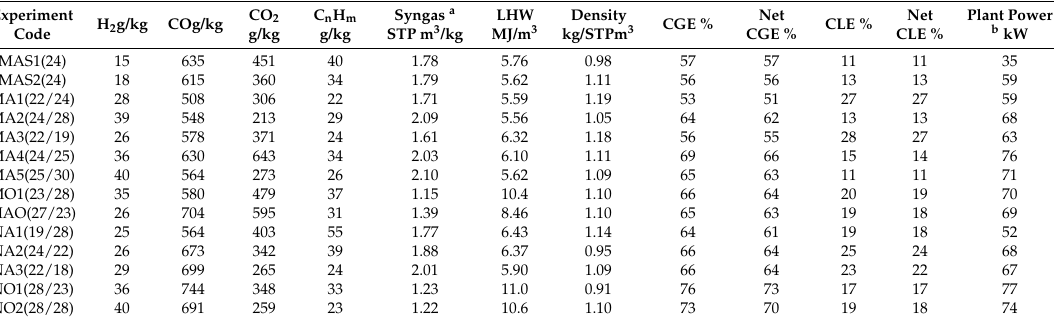
Table 4. Process yields and plant performances.